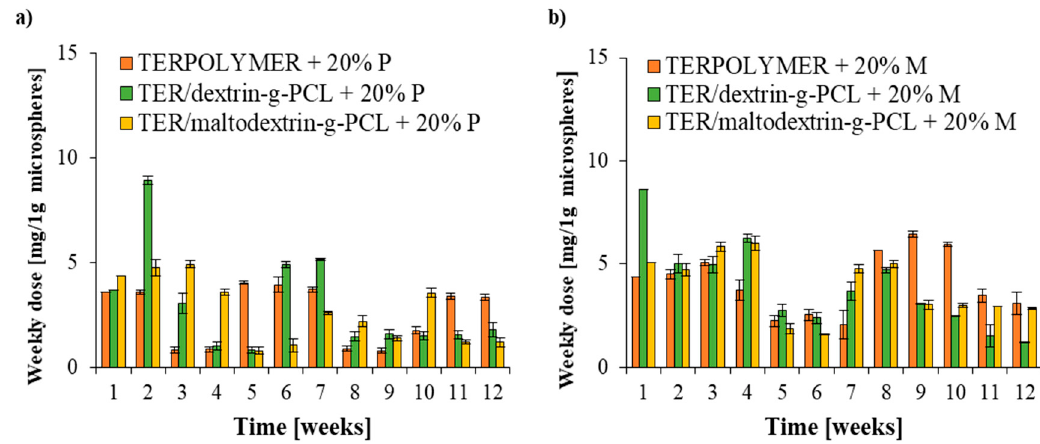
Figure 7. Weekly dose release of ( a ) pendimethalin and ( b ) metazachlor from microspheres into water.